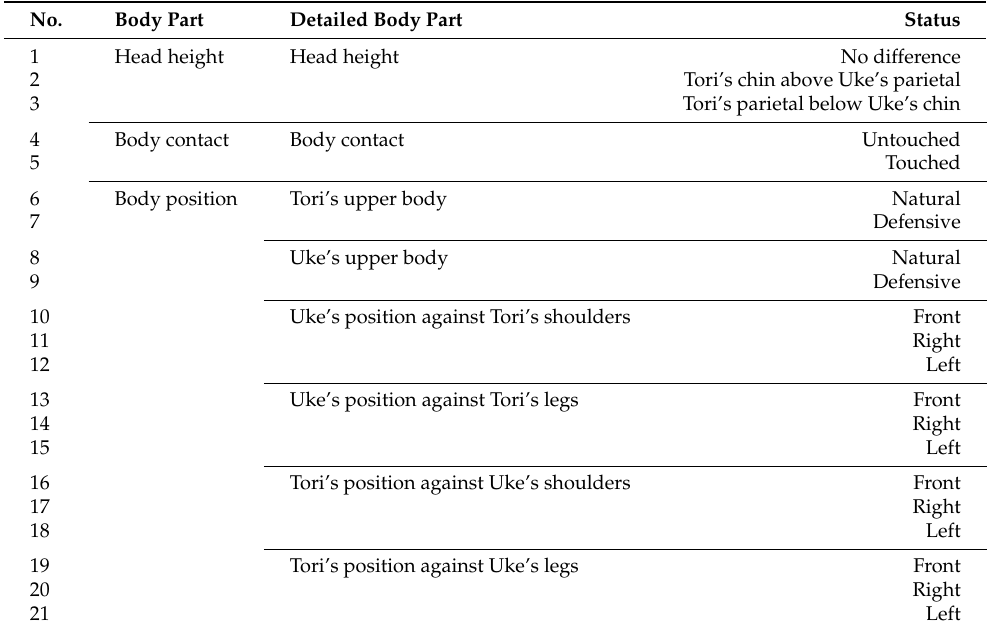
Table 1. Candidate factors for each body part regarding the throwing techniques in